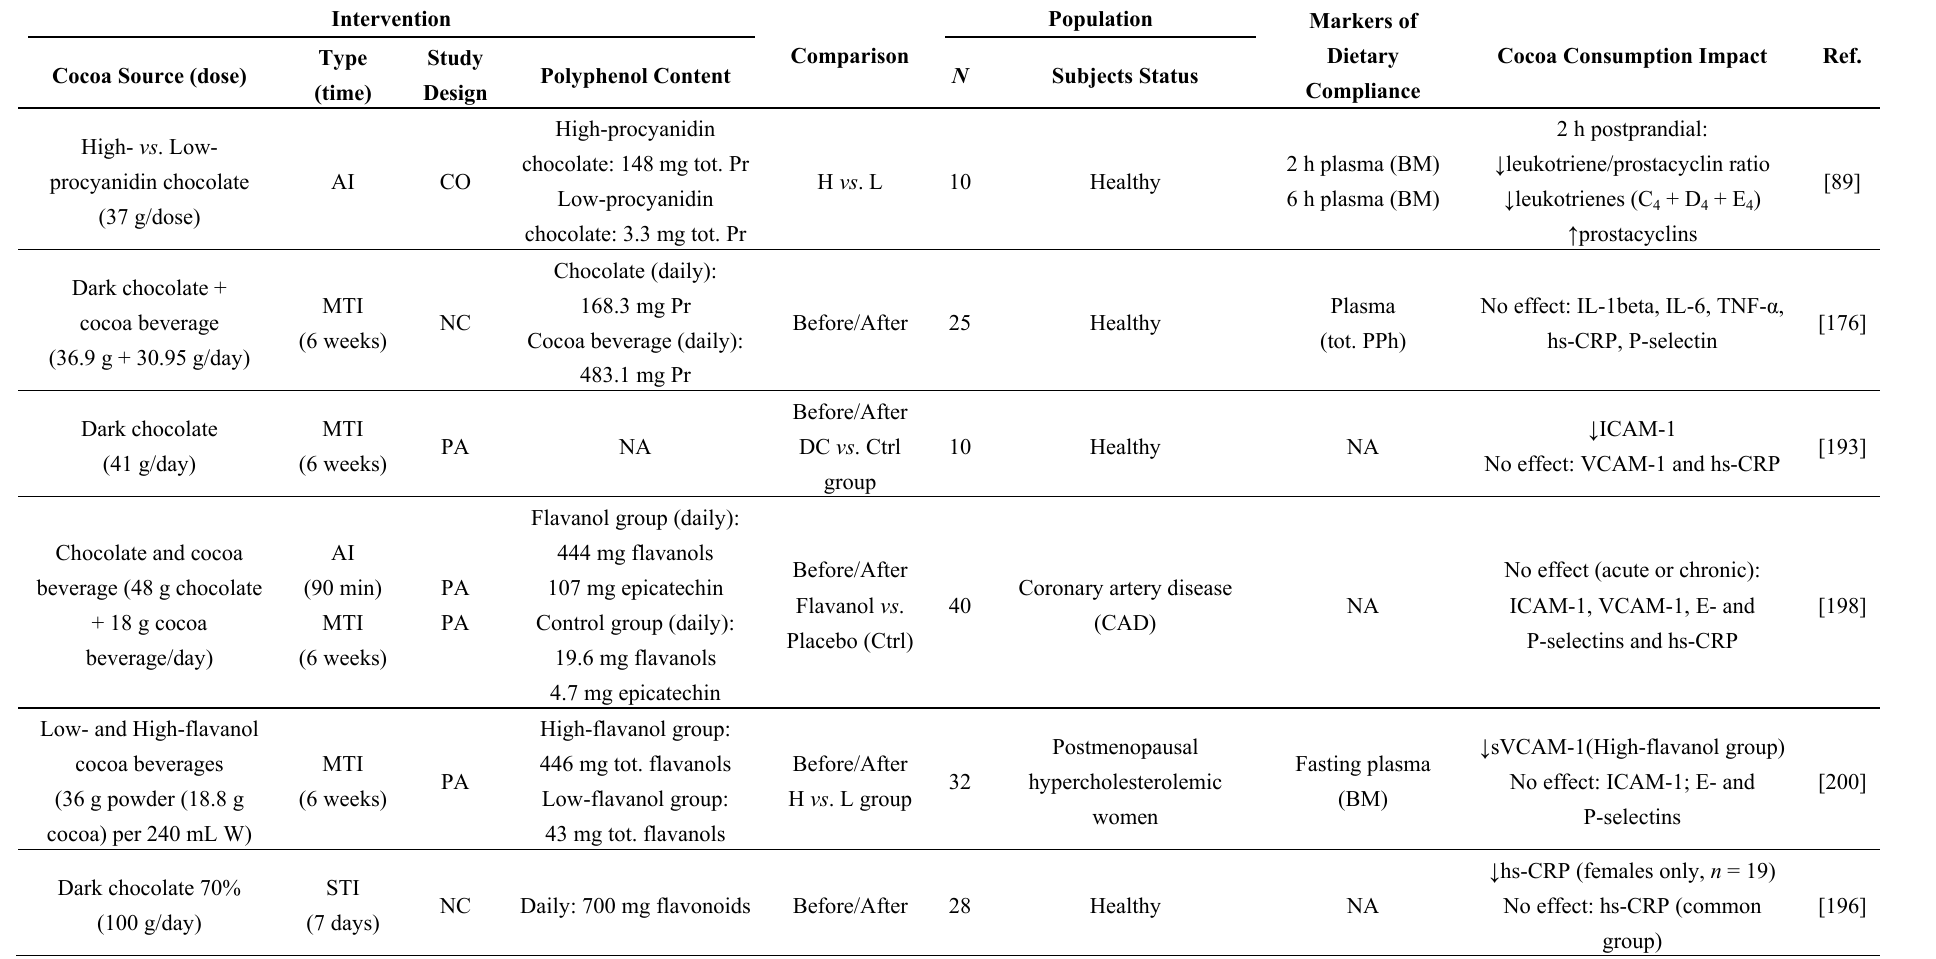
Table 1. Human intervention studies considering the relationship between cocoa polyphenols and cardiovascular disease (CVD)-related inflammatory markers (studies are presented in chronological order). Ref. =